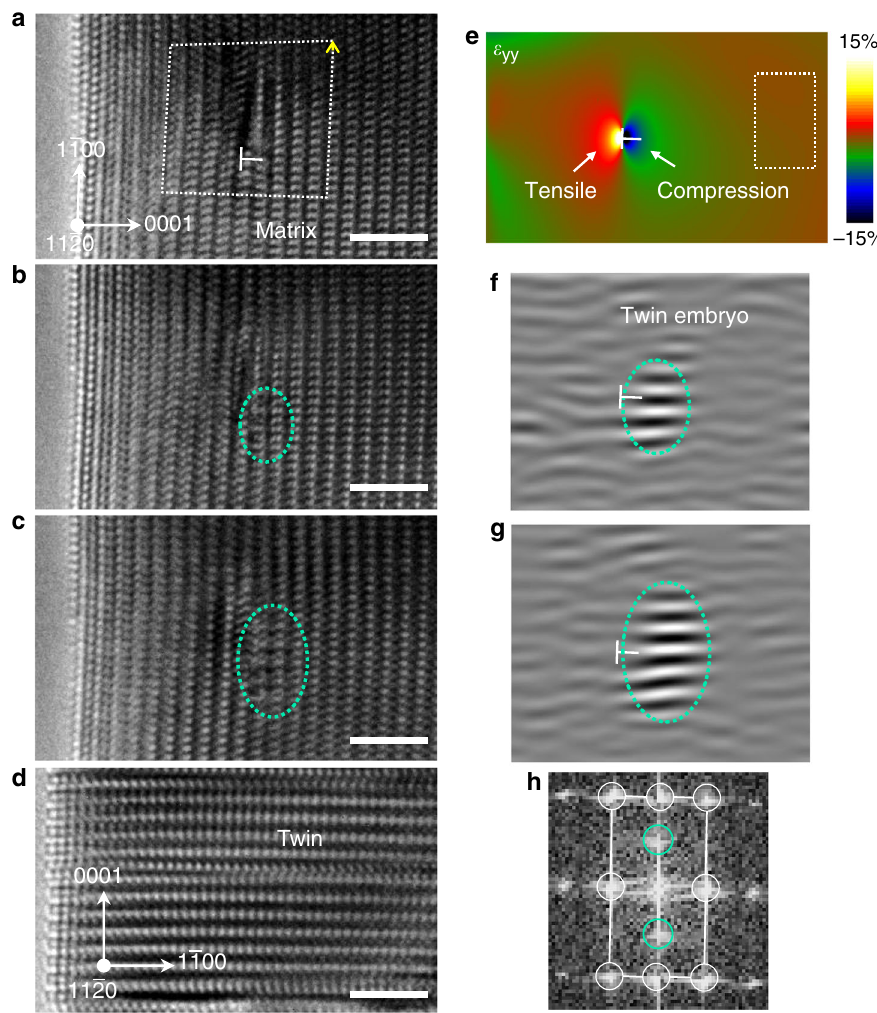
Fig. 5 Twinning nucleation assisted by the strain fi eld of a matrix dislocation. a – d Sequential HRTEM images showing the nucleation of a twin embryo near the dislocation core (indicated by the “ ├ ” symbol). The crystal was under <1 − 1 0 0 > -oriented compression and viewed along the <1 1 − 2 0> direction. White dashed line in a is the Burgers circuit which indicates an < a > component in the Burgers vector (indicated by the yellow arrow) of the dislocation. Detailed analysis of the Burgers vector is shown in Supplementary Fig. 5. e Mapping of the strain normal to the parent prismatic plane ( ε yy ) generated by the dislocation core, by geometrical phase analysis. Boxed region is the reference region for the geometrical phase analysis (see ref. 56 for more details). f – g Inverse fast Fourier transformations of the TEM snapshots in b , c , respectively, using the (0 0 0 1) re fl ections of the twin (indicated by turquoise-circles in h ). Turquoise dotted circles in b , c , f , g mark the twin embryo. White circles and lines in h indicate the reciprocal lattice of the matrix. Scale bars in a – d , 2